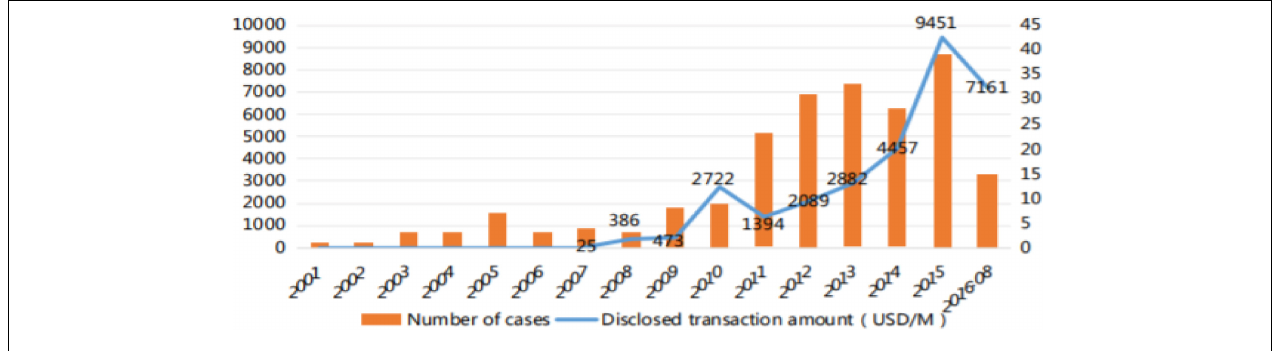
FIGURE 1 | Source (He, 2018; Zhang, 2020).